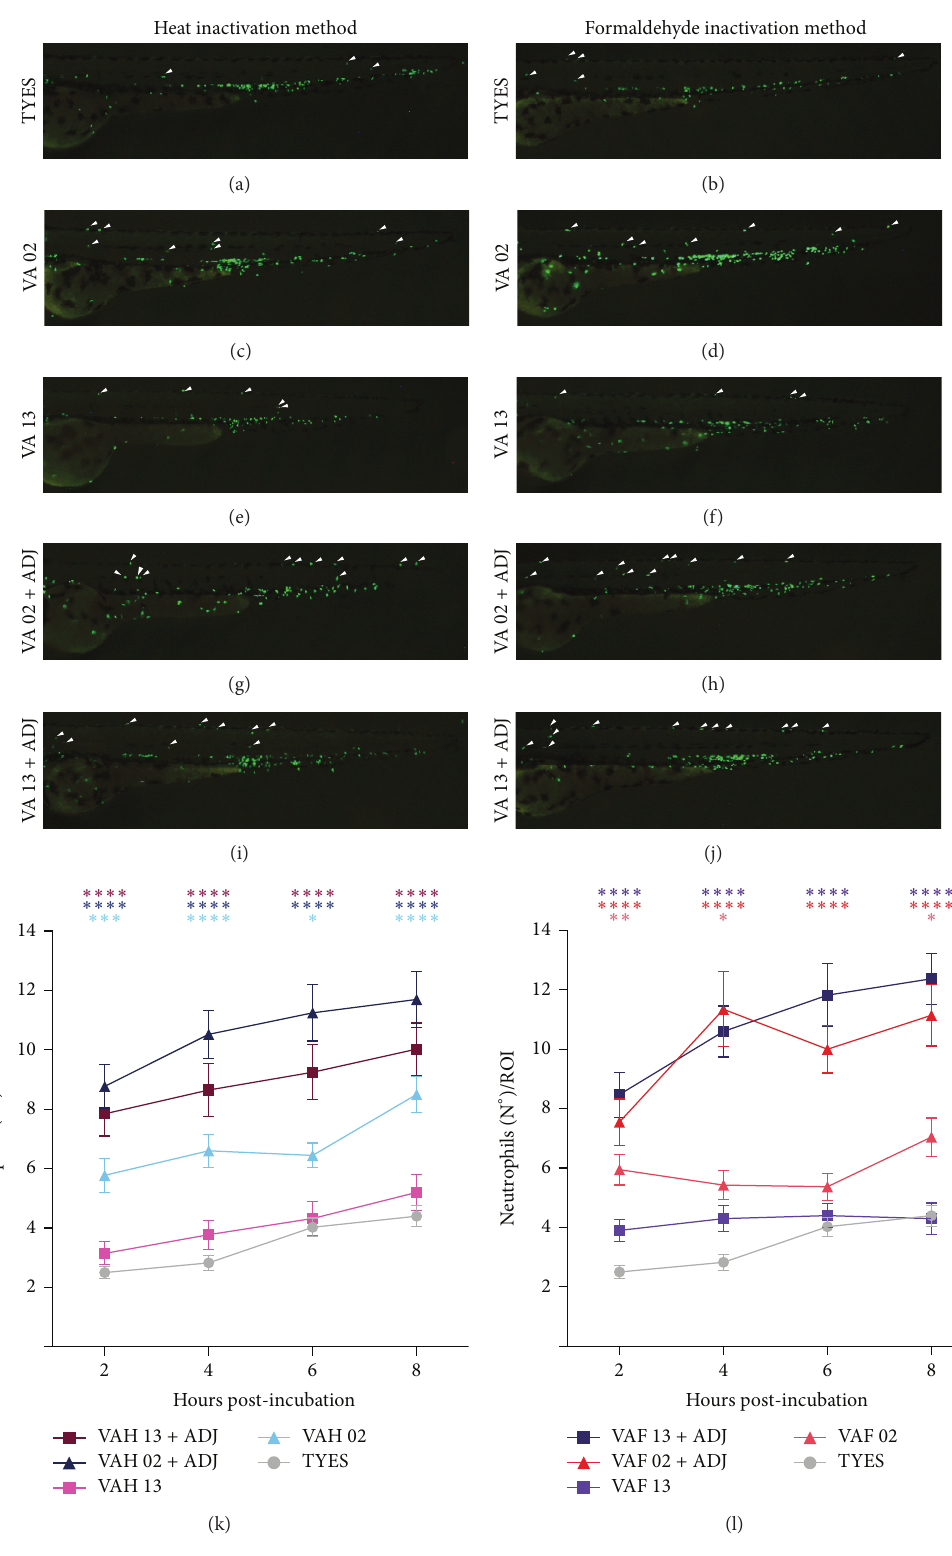
Figure 2: Effect on innate immune response triggered by freshly prepared vaccines against F. psychrophilum . ((a)–(j)) Representative images of zebrafish tails from larvae at 58 hpf. ((k) and (l)) Graph quantifying the number of neutrophils outside of the CHT (ROI), showing the effect on the innate immune response in larvae bath-vaccinated with (k) heat inactivated bacteria or (l) formaldehyde. Statistical analysis was performed using two-way ANOVA. All embryos ((a)–(j)) were oriented anterior to the left, with the dorsal on top. Data represent the mean ± standard error from three independent experiments with 15 larvae each. ∗ 𝑃 value < 0.05, ∗∗∗ 𝑃 < 0.001 , and ∗∗∗∗ 𝑃 < 0.0001